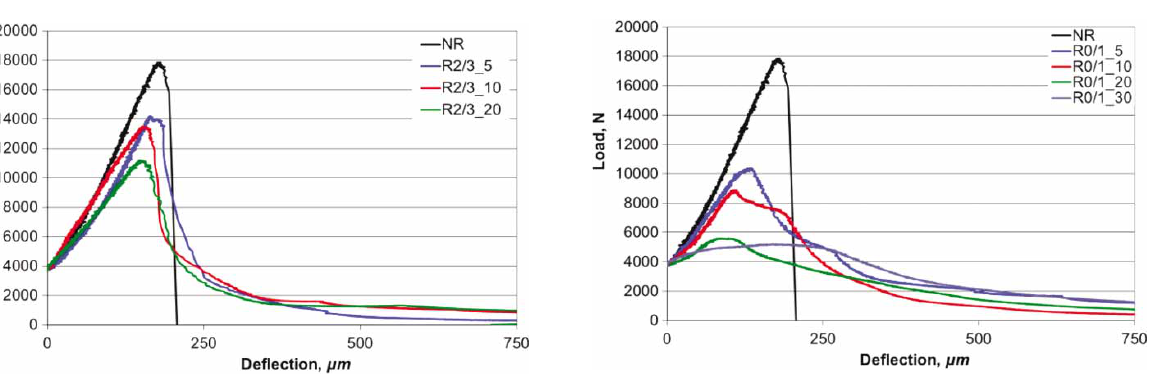
Fig. 7. The function of stress and deflection when 2/3 fraction is used